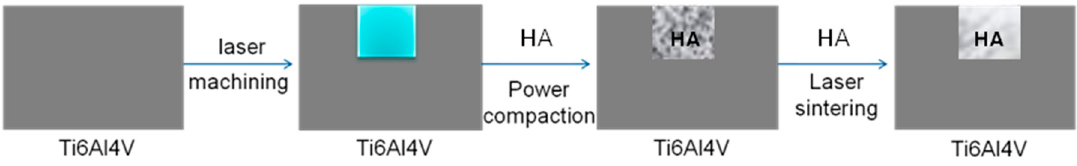
Figure 15. Schematic representation of the experimental procedure used to produce laser sintered Ti6Al4V doped HA structures [94]. Reprinted with permission from reference [94] 2019 Elsevier.